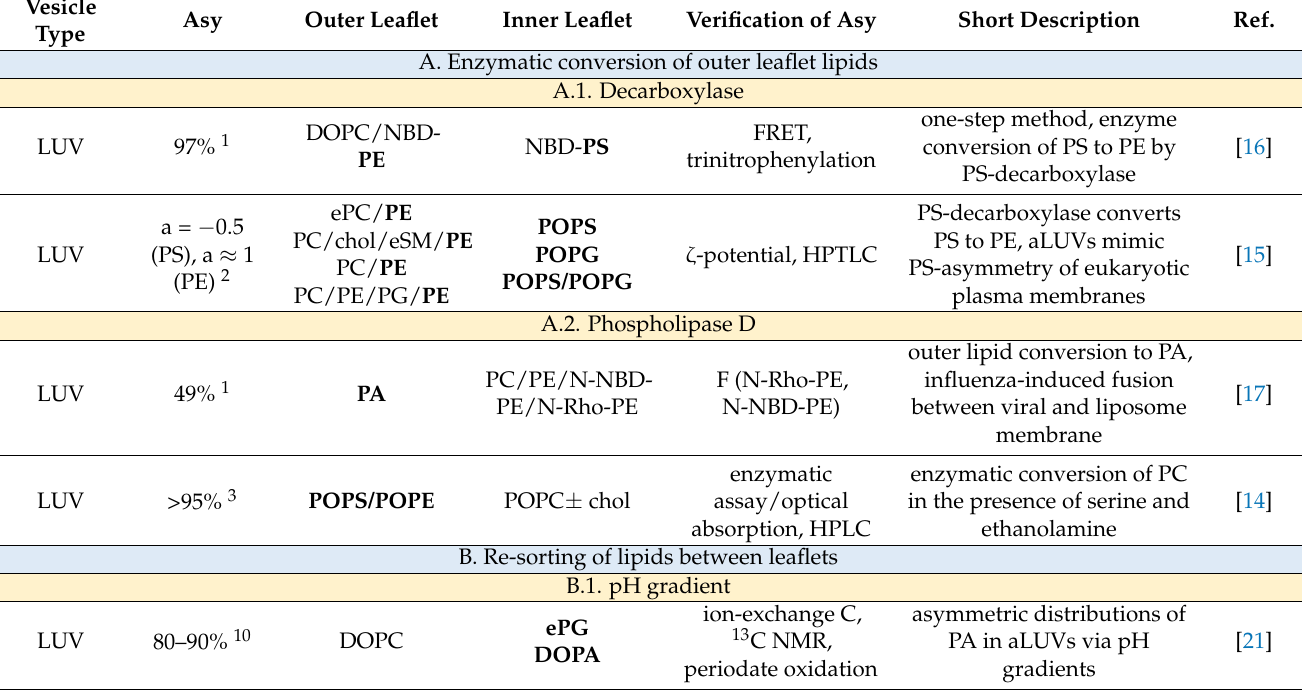
Table 1. Summary of protocols for in-vitro preparation of lipid-asymmetric vesicles. Articles are listed by category (A–D) and date of publication. Selected features are shown including vesicle type, degree of asymmetry (asy), outer leaflet and inner leaflet composition, asymmetry verification method and a short description of the respective article. Lipids primarily intended to be asymmetrically present in one leaflet are highlighted in bold. Lipids in light font are matrix or acceptor lipids that may be present in both leaflets. Note that the degree of asymmetry is interpreted in different ways; thus, footnotes are inserted to provide more detailed